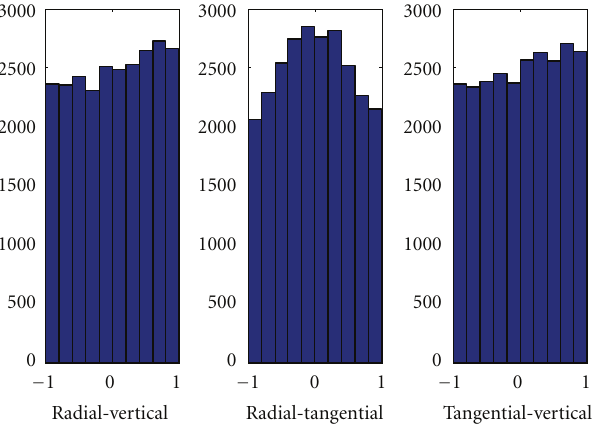
Figure 15: Histograms of anisotropy coe ffi cients for small chamber with dimensions D x = 1m, D y = 0 . 9m, and D z = 0 . 8m operating around 750